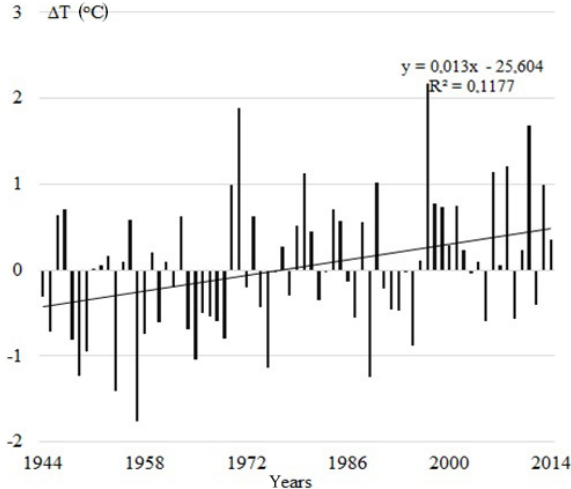
Figure 9. Deviation of annual temperature from the long-term av- erage (1944–2016) and trend for the Khorog meteorological station.